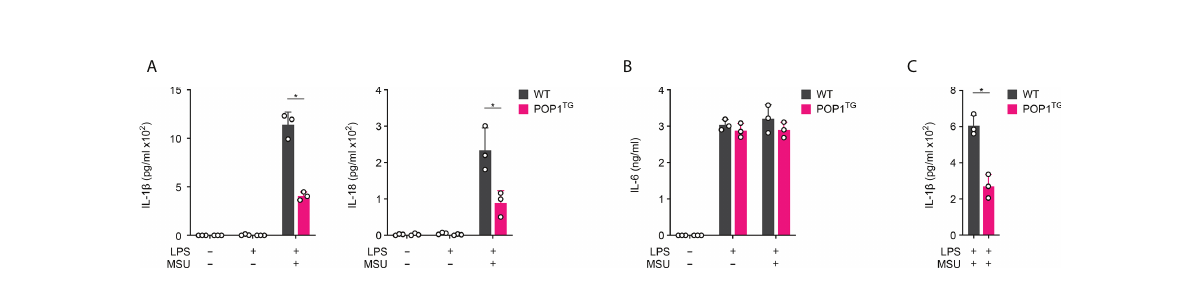
FIGURE 3 POP1 inhibits in fl ammasome-dependent cytokine release in BMDM. (A, B) Wild type (WT) and POP1 transgenic (POP1 TG ) BMDM were primed with LPS and treated with MSU crystals as indicated and culture supernatants (SN) were analyzed for secreted (A) IL-1 b and IL-18 and (B) IL-6 by ELISA (n = 3 ± s.d.). (C) Peritoneal macrophages were treated as above, and SN were analyzed for secreted IL-1 b by ELISA (n = 3 ± s.d.). *p <